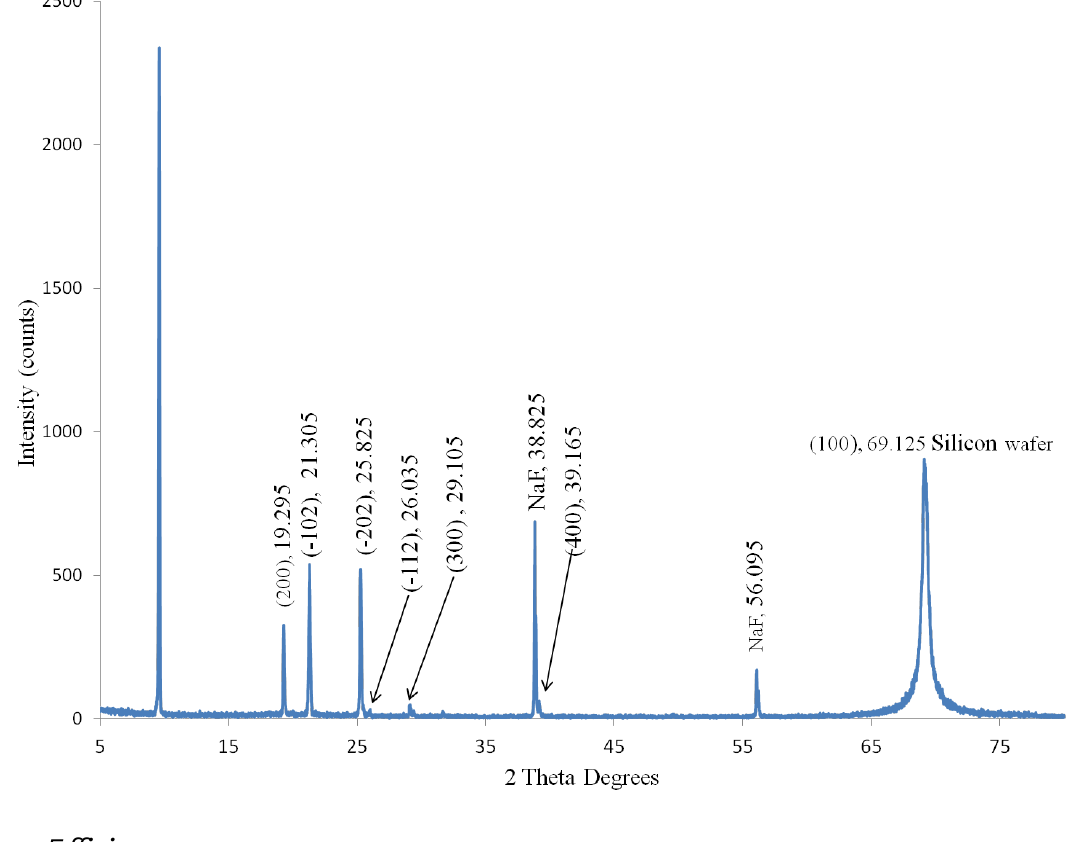
Figure 8. Anthracene X-ray diffraction (XRD) from bare anthracene fibers etched from quartz on a (100) silicon wafer. The (100) anthracene peak at 9.625 2 Theta degrees corresponds to the growth direction. Diffraction angles for peaks all correlate to the anthracene XRD card data [36], sodium fluoride [37], and silicon. The crystal orientation was taken from the ICCD data file